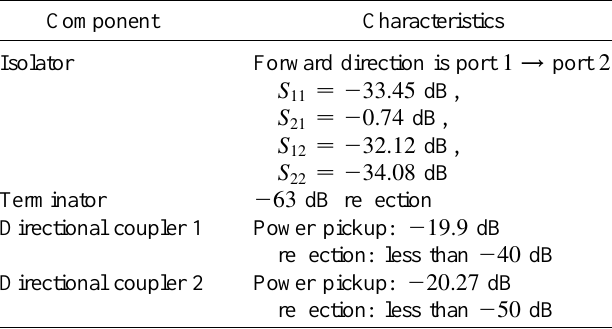
TABLE II. Characteristics of the components.